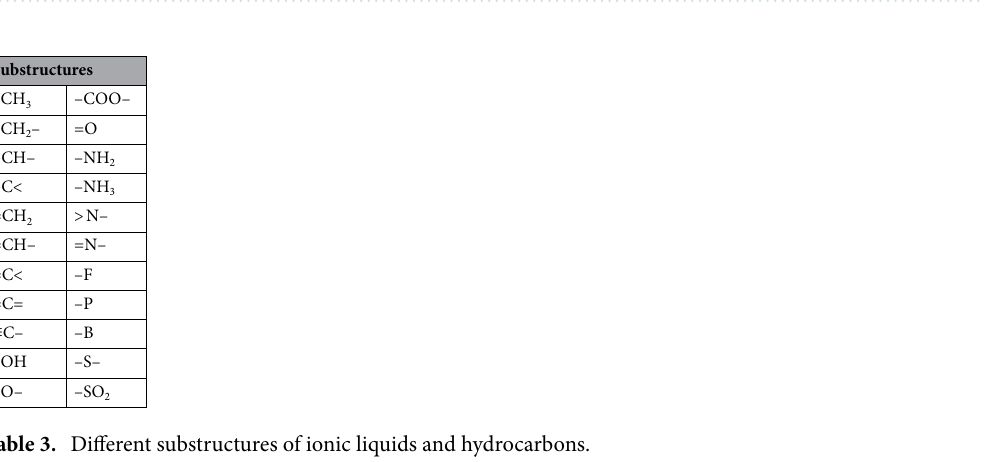
Table 2. Statistical description of databank used in the current study.